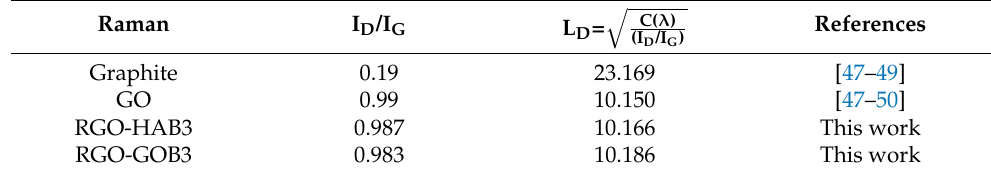
Table 3. Raman characteristic parameters of graphite, graphene oxide (GO) and reduced graphene oxide (RGO) samples.